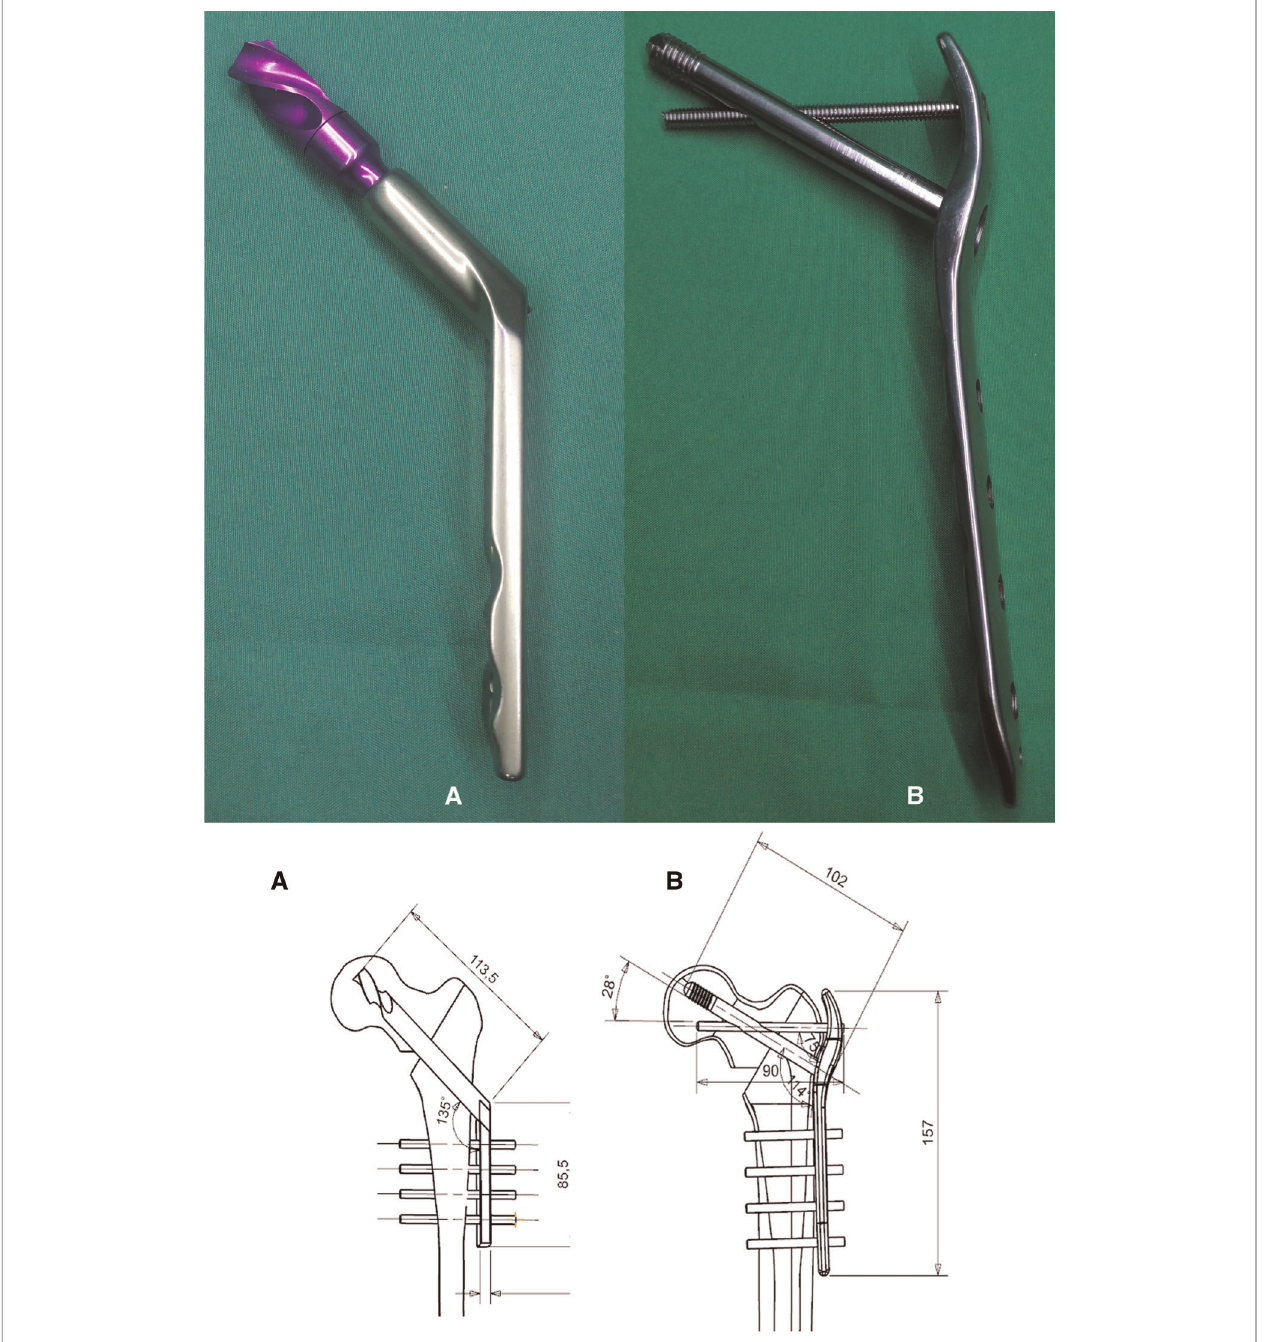
FIGURE 1 | Diagram, detail, and speci fi cations of internal fi xation devices; ( A ) DHS; and ( B )